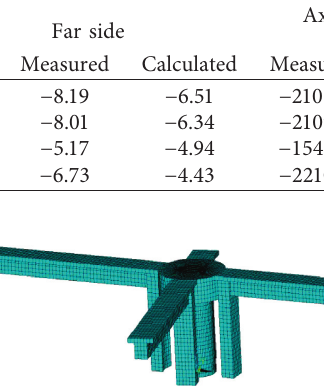
Figure 12: Finite element model of column 5 on the 15 th